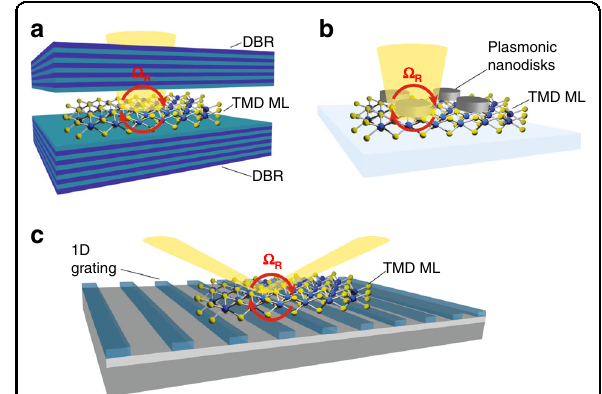
Fig. 1 Optical Resonators strongly coupled to TMDs. a Schematic of a vertical cavity made of DBRs, embedding a TMD monolayer (ML) in strong coupling regime. b Scheme of a plexciton system with a TMD monolayer strongly coupled to silver plasmonic nanodisks. c Sketch of a photonic crystal slab made of a 1D grating coupled to a TMD